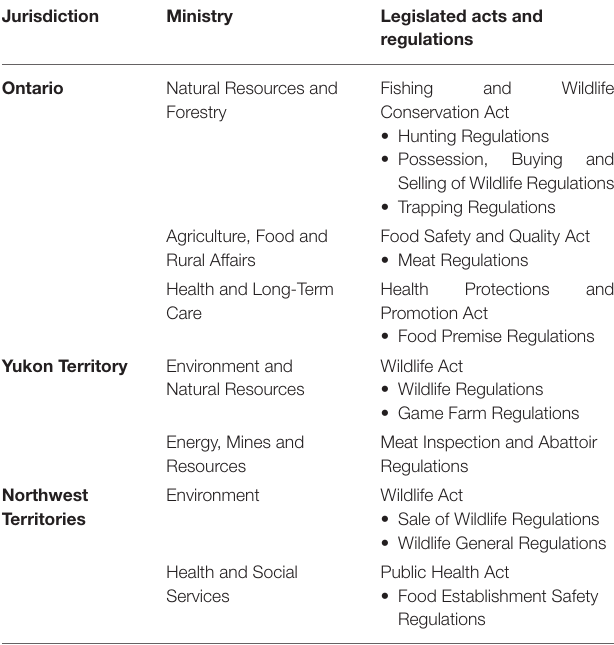
TABLE 1 | Identified policies organized by ministry.